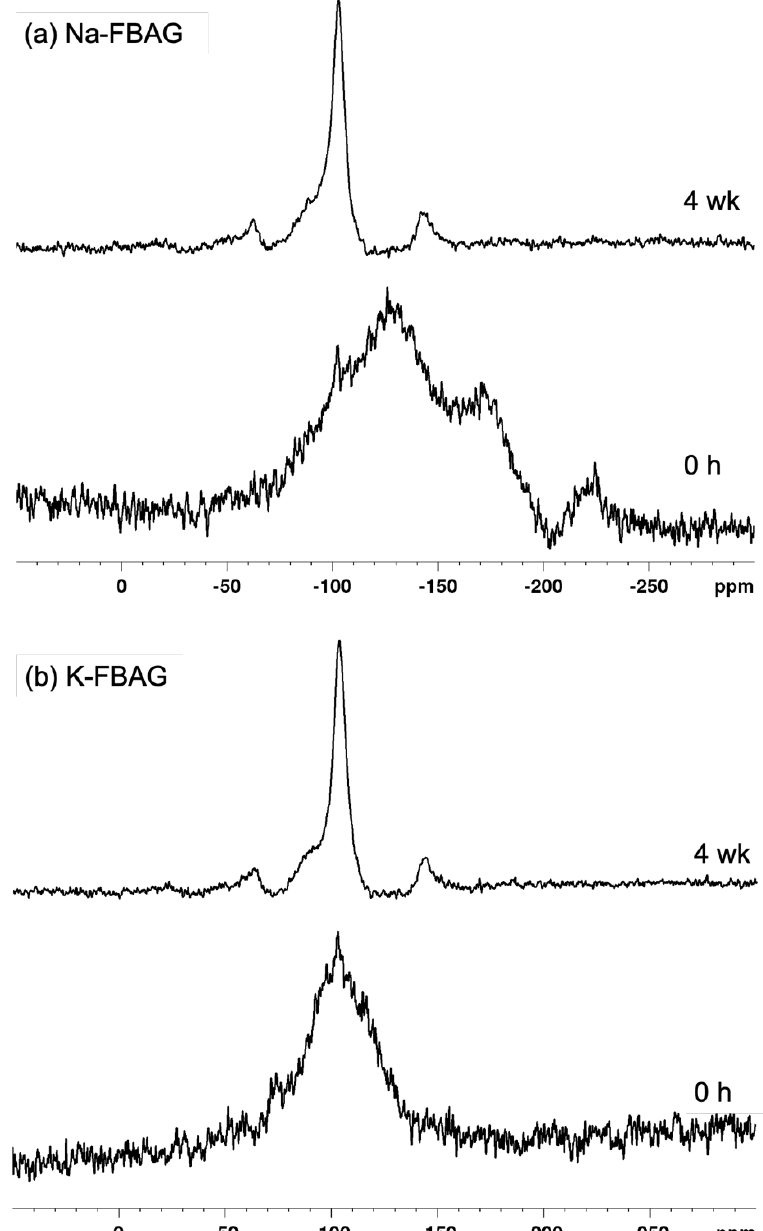
Figure 6. 19 F MAS-NMR spectra for ( a ) Na-FBAG and ( b ) K-FBAG.